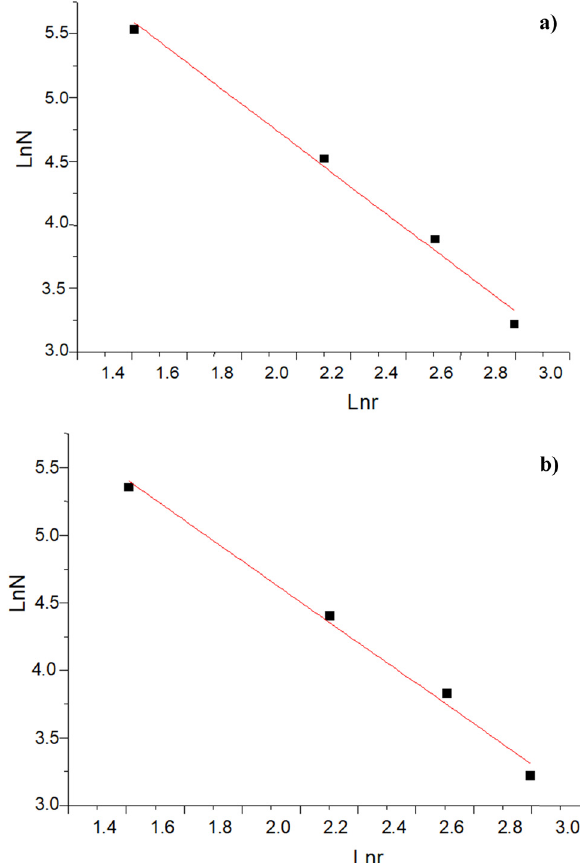
Figure 17: Double logarithmic fi tting of natural aggregate ( a ) and Type I recycled aggregate ( b ) .